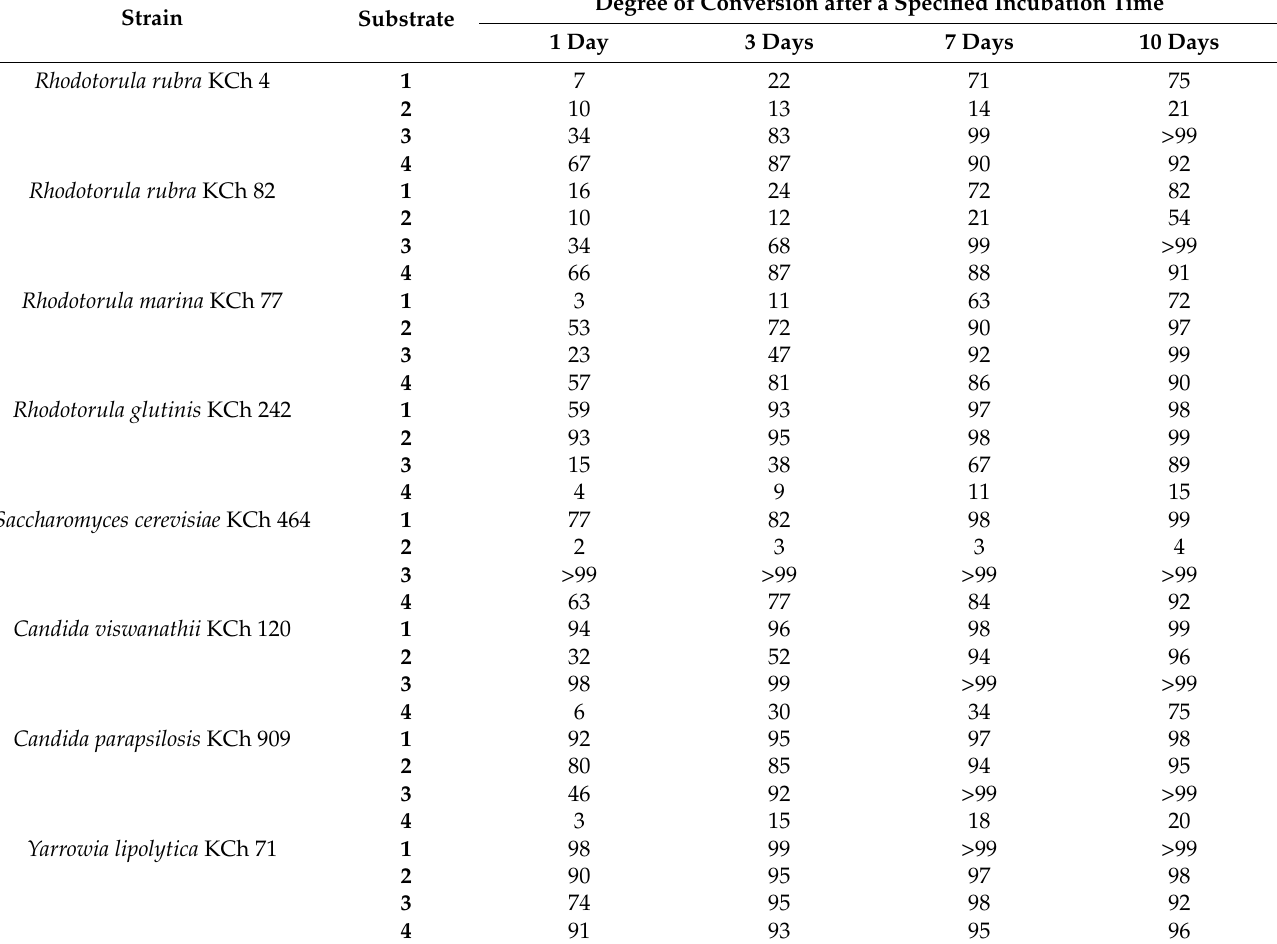
Table 1. Percentage of biotransformation products of 2 (cid:48) -hydroxybromochalcones on the 1st, 3rd, 7th and 10th day of the